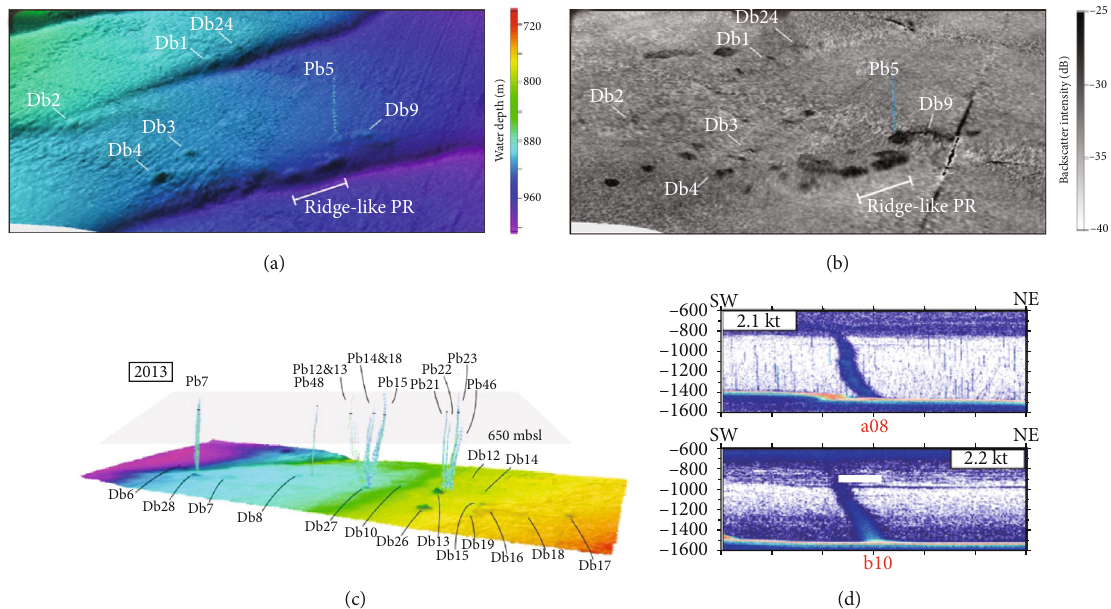
Figure 4: The morphological and hydroacoustic features surrounding the cold seeps of the Okinawa Trough. (a, b) Dome-like and ridge-like positive reliefs and their nearby backscattering features at the level of the seabed (modi fi ed from [15]). (c) Acoustic fl ares above the cold seeps (from [16]). (d) Gas plumes indicating the escape of free gases from marine sediments (from [14]).